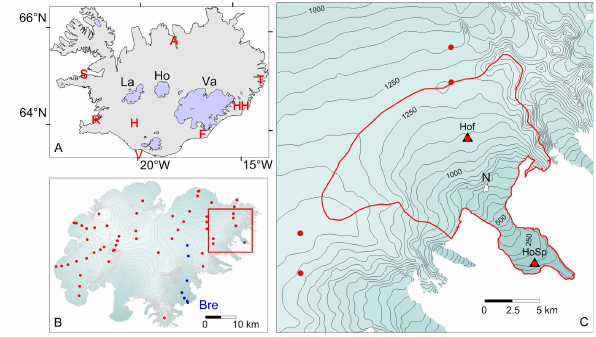
Fig. 1. (A) Iceland and the largest ice caps, Vatnajökull (Va), Hofsjökull (Ho) and Langjökull (La). Locations of the weather sta- tions, used to reconstruct the temperature and precipitation records, are shown with letters: Reykjavík (R), Fagurhólmýri (F), Hæll (H), Stykkishólmur (S), Teigarhorn (T), Vestamannaeyjar (V), Akureyri (A) and Hólar in Hornafjörður (HH). (B) The surface topography of Vatnajökull ice cap. Dots show the sites of mass balance and veloc- ity measurements, blue dots show the location of the mass balance stakes at Breiðamerkurjökull (Bre). The red box indicates the posi- tion of the frame to the right. (C) Hoffellsjökull surface topography in 2001. The ice divide and the model domain are indicated with the red curve enclosing a glaciated area of ∼ 212km 2 in 2001. Black triangles show the locations of automatic weather stations on the glacier. N is the location of the central nunatak Nýju